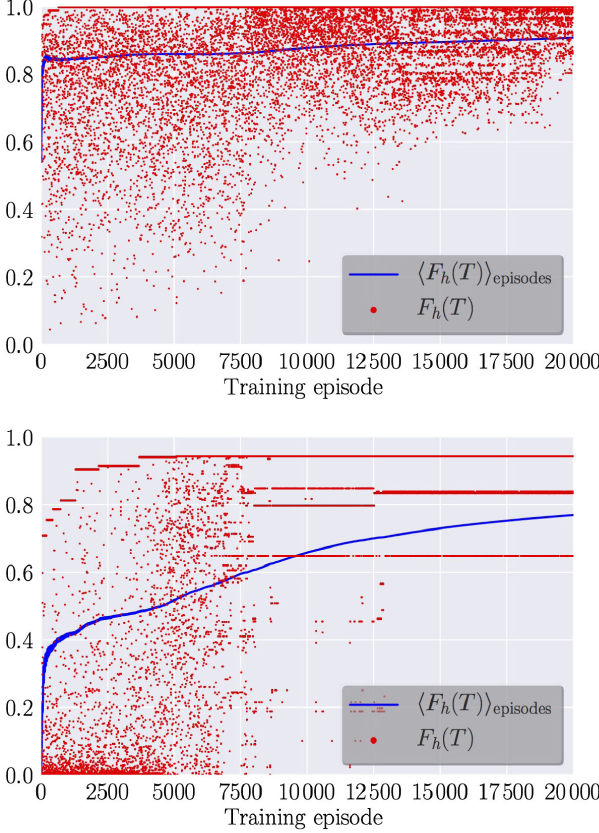
FIG. 2. Learning curves of the RL agent for the problems from Sec. III for L ¼ 1 at T ¼ 2 . 4 (upper panel) (see Video 7 of Supplemental Material [62]) and L ¼ 10 at T ¼ 3 . 0 (lower panel) (see Video 8 of Supplemental Material [62]). The red dots show the instantaneous reward (i.e., fidelity) at every episode, while the blue line shows the cumulative episode average. The ramp-up of the RL temperature β gradually suppresses exploration over RL time which leads to a smoothly increasing average fidelity. The time step is δ t ¼ 0 . 05